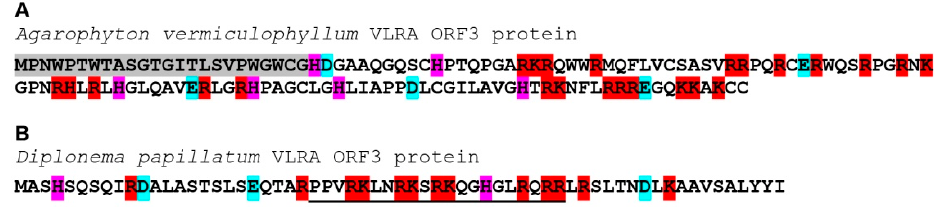
Figure 4. Amino acid sequence of the ORF3 protein encoded by Agarophyton vermiculophyllum ( A ) and Diplonema papillatum ( B ) VLRAs. Positively charged residues are shown in red, negatively charged residues are in blue, and histidine residues are in pink; uncharged N-terminal residues are shaded. The putative NLS sequence is underlined.